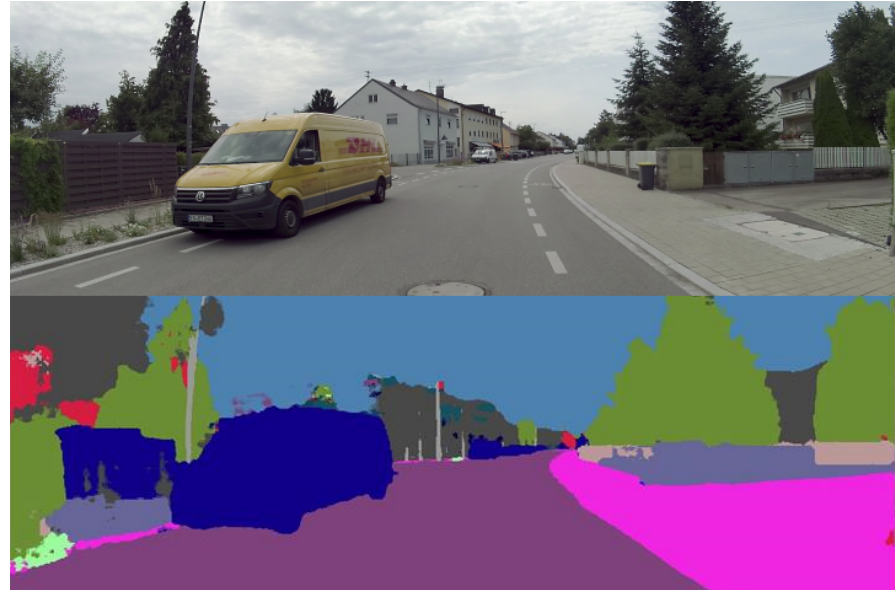
Figure 2. Top: original front camera image; bottom: semantic segmentation output of the given image using the ERFNet segmentation network